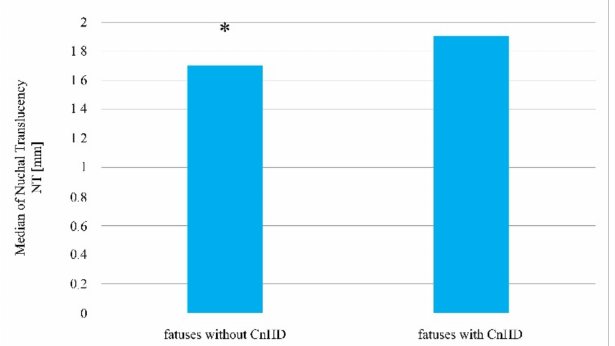
Figure 6. The median nuchal translucency thickness among fetuses with a diagnosed congenital non- heart defect in comparison to fetuses in which such a possibility was excluded, amongst women who became pregnant after the induction of ovulation and sexual intercourse. * Statistically significant difference (Mann–Whitney U test; p <